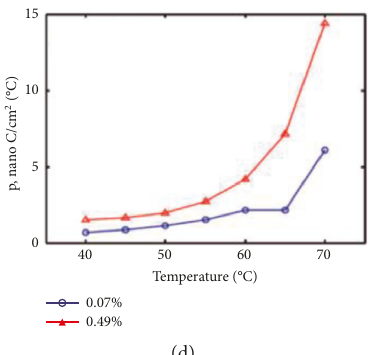
Figure 17: (a) Diagram of the conductive network in smart CNFC [93]. (b) Comparison of CNFC parameters with different water contents [93]. (c) Relationship of dielectric constants ( ε ′ ) of CNFC with temperature [94]. (d) Relationship of pyroelectric coefficient of CNFC with temperature